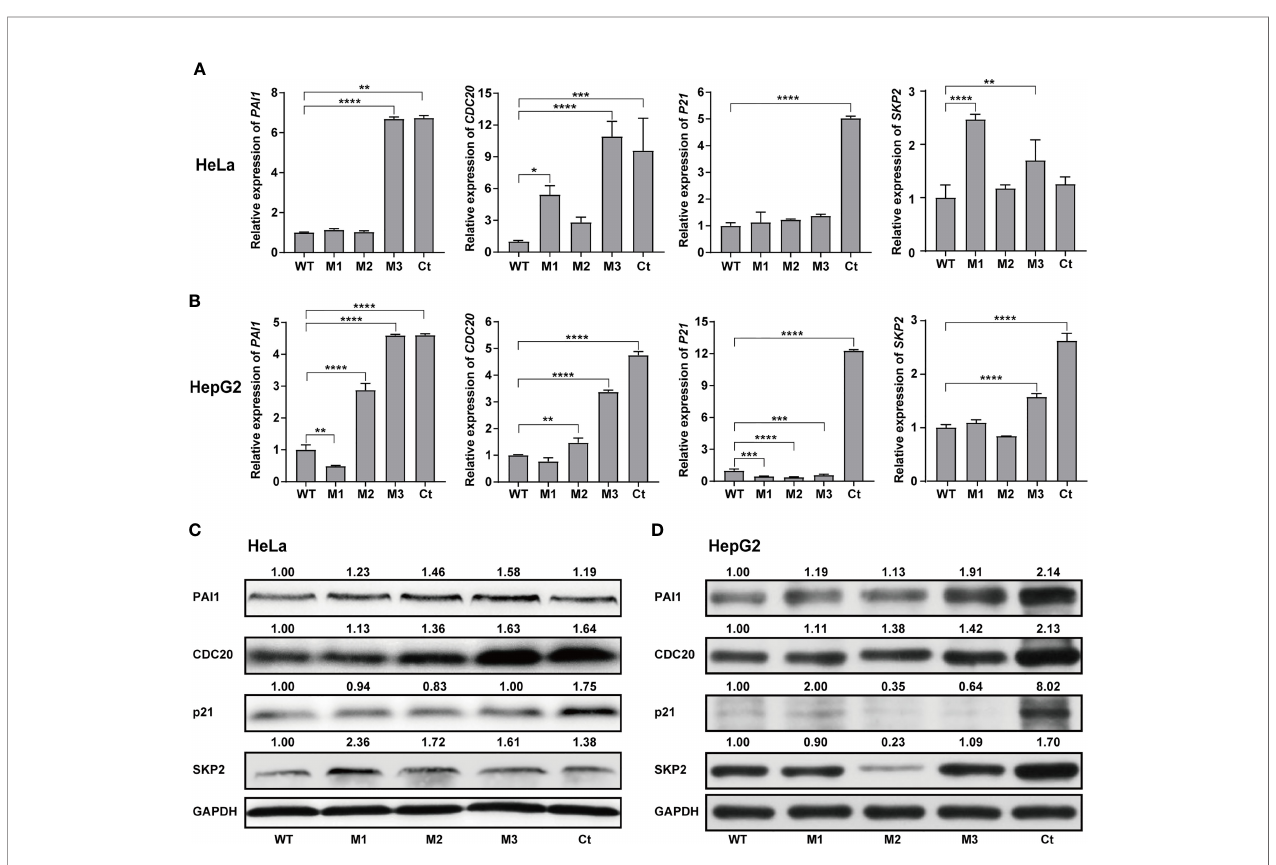
FIGURE 6 | Effects of the HBx mutants on the expression of functional molecules in vitro. (A) Ectopic expression of Wt-HBx or HBx mutants affects the mRNA levels of PAI1 , CDC20 , P21 , and SKP2 in HeLa cells. (B) Ectopic expression of Wt-HBx or HBx mutants affects the mRNA levels of PAI1 , CDC20 , P21 , and SKP2 in HepG2 cells. (C) Ectopic expression of Wt-HBx or HBx mutants affects the protein levels of PAI1, CDC20, P21, and SKP2 in HeLa cells. (D) Ectopic expression of Wt-HBx or HBx mutants affects the protein levels of PAI1, CDC20, P21, and SKP2 in HepG2 cells. * P < 0.05; ** P < 0.01; *** P < 0.001; **** P <